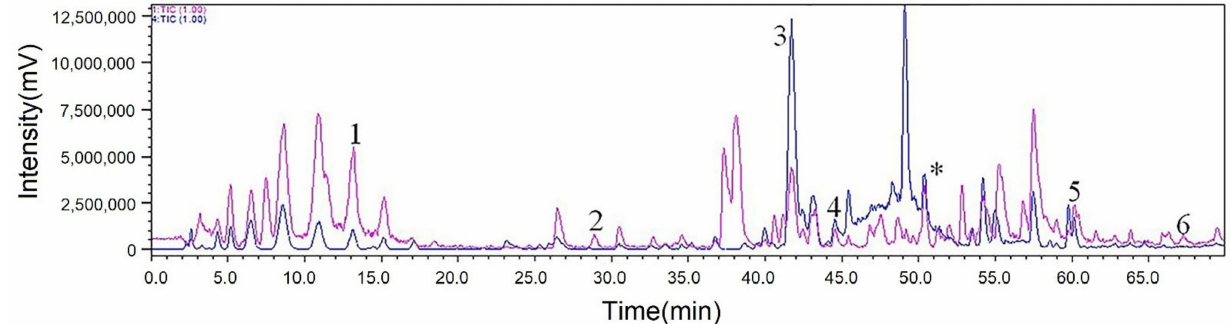
Figure 6. Total ion chromatograms of ligands (positive ion mode: red line; negative ion mode: blue line). The peak “*” which appeared to be a fatty acid compound.2.7. Identification of Ligands and Evaluation of Their Cytotoxicity.